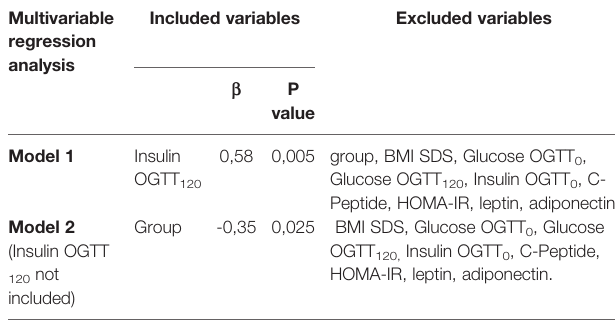
TABLE 3 | Pearson ’ s correlation analysis between irisin levels and anthropometric and biochemical parameters in the study populations as a whole. Parameters